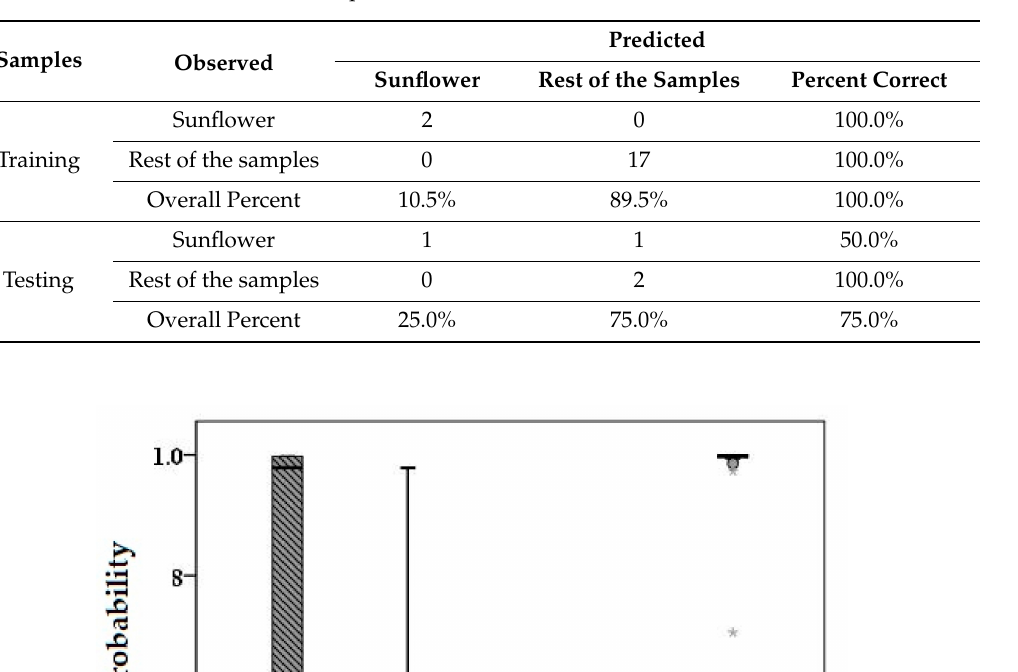
Table 2. Oil sample classification obtained after BP-ANN.